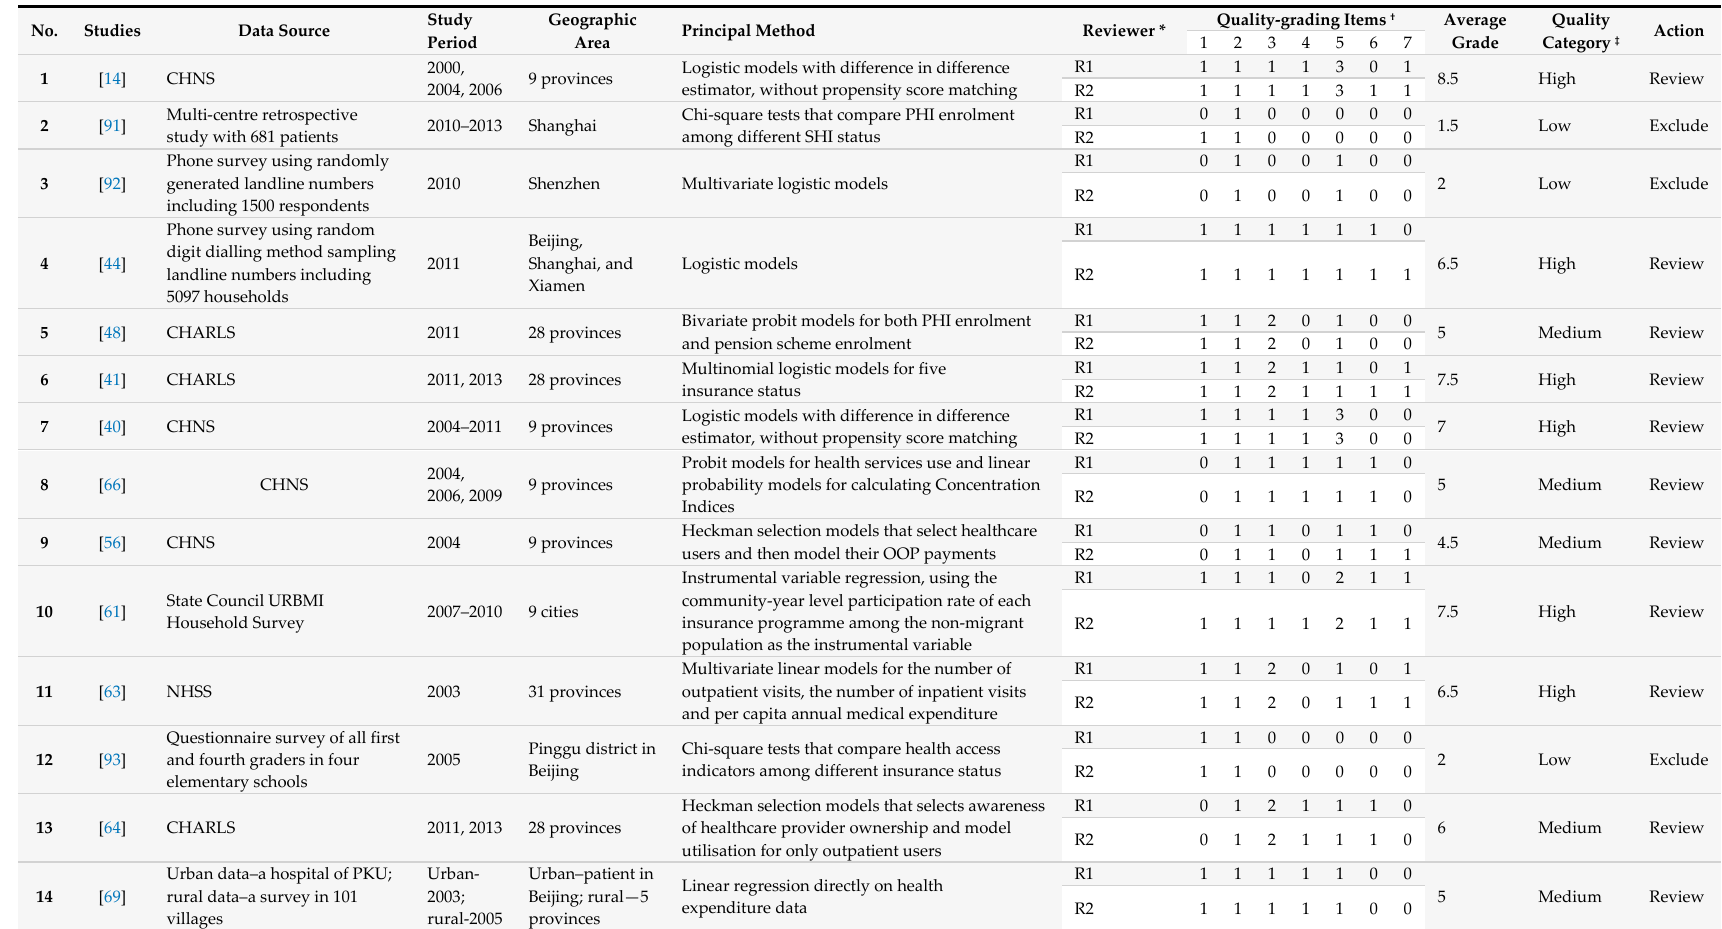
Table A1. Characteristics of included studies and quality assessment results. Int. J. Environ. Res. Public Health 2020 , 17 , x FOR PEER